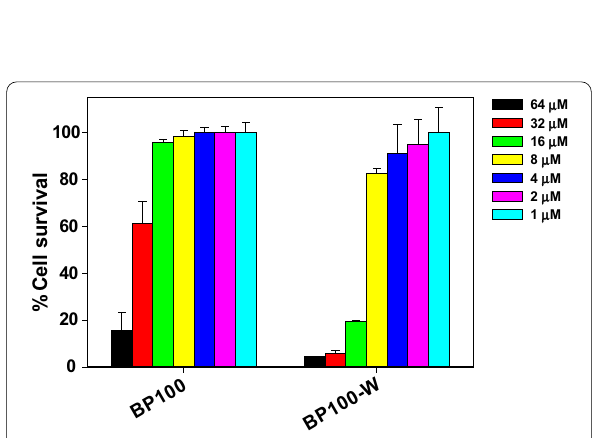
Fig. 5 Cytotoxicities of BP100 and BP100-W against RAW264.7 mouse